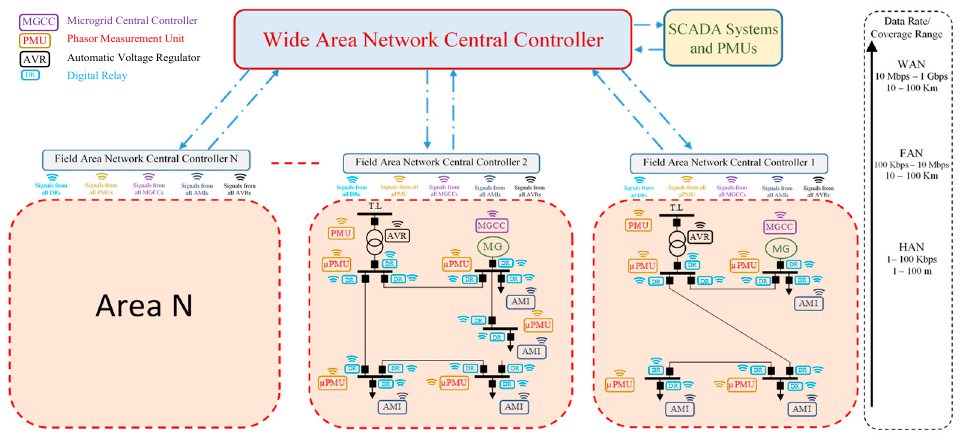
Figure 5. Conceived centralized multi-layer control hierarchy for smart grids.